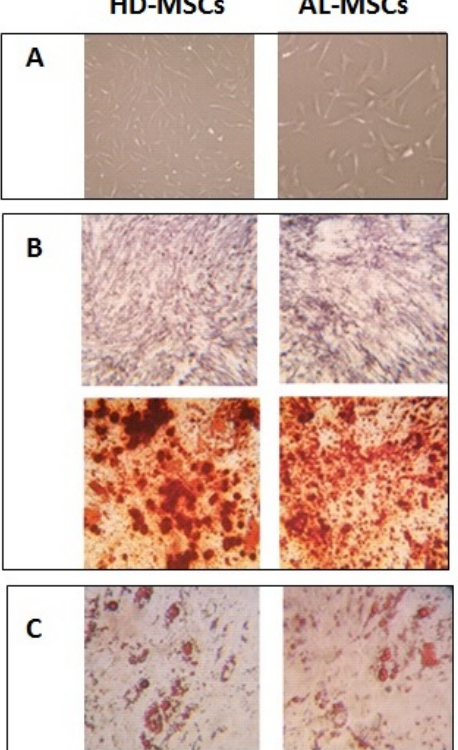
serum-free light-chain levels.